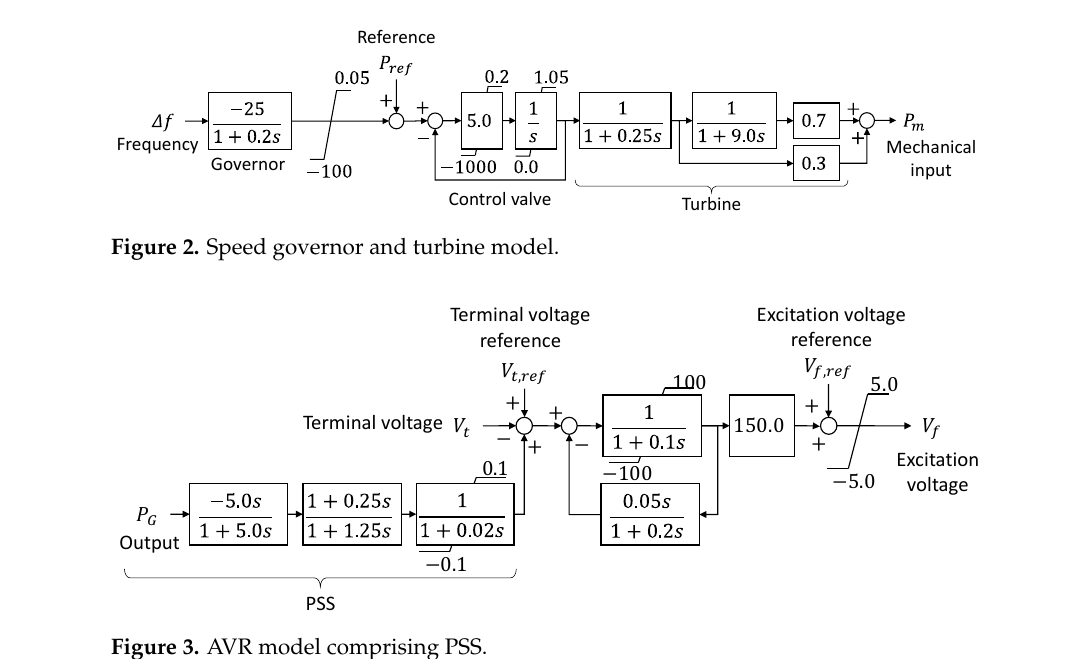
Figure 3. AVR model comprising PSS.